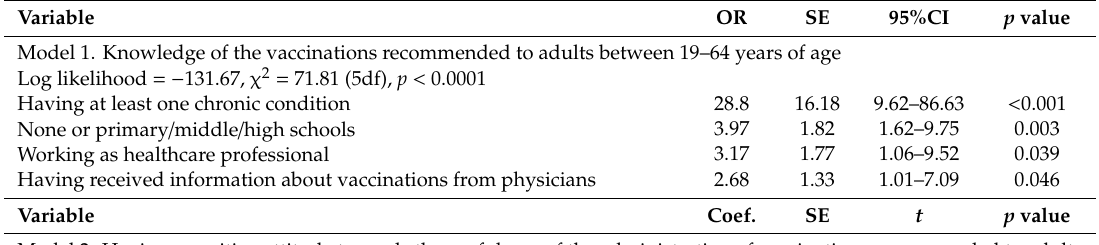
Table 3. Multivariate logistic and linear regression analysis results for estimates of associations of the di ff erent outcomes of interest among parents with several